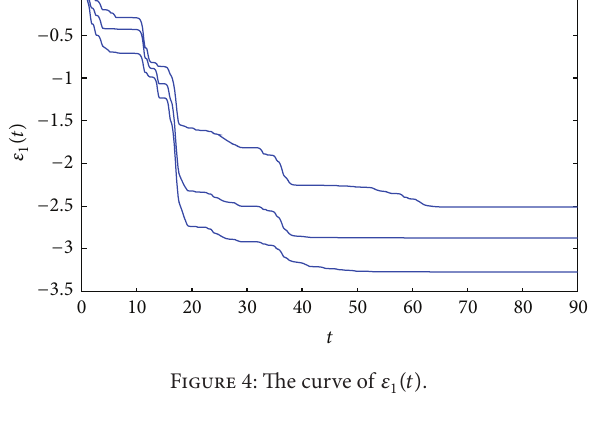
Figure 4: The curve of 𝜀 1 (𝑡) .